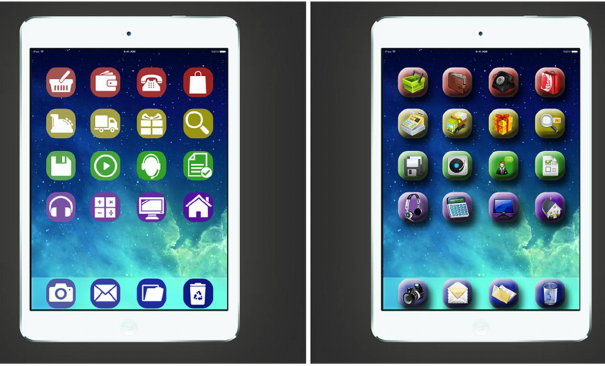
Figure 4. Screens displayed to users in Step 4 (click on the icon for customer support).